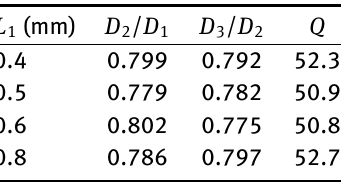
Table 3: Optimal results for various computational